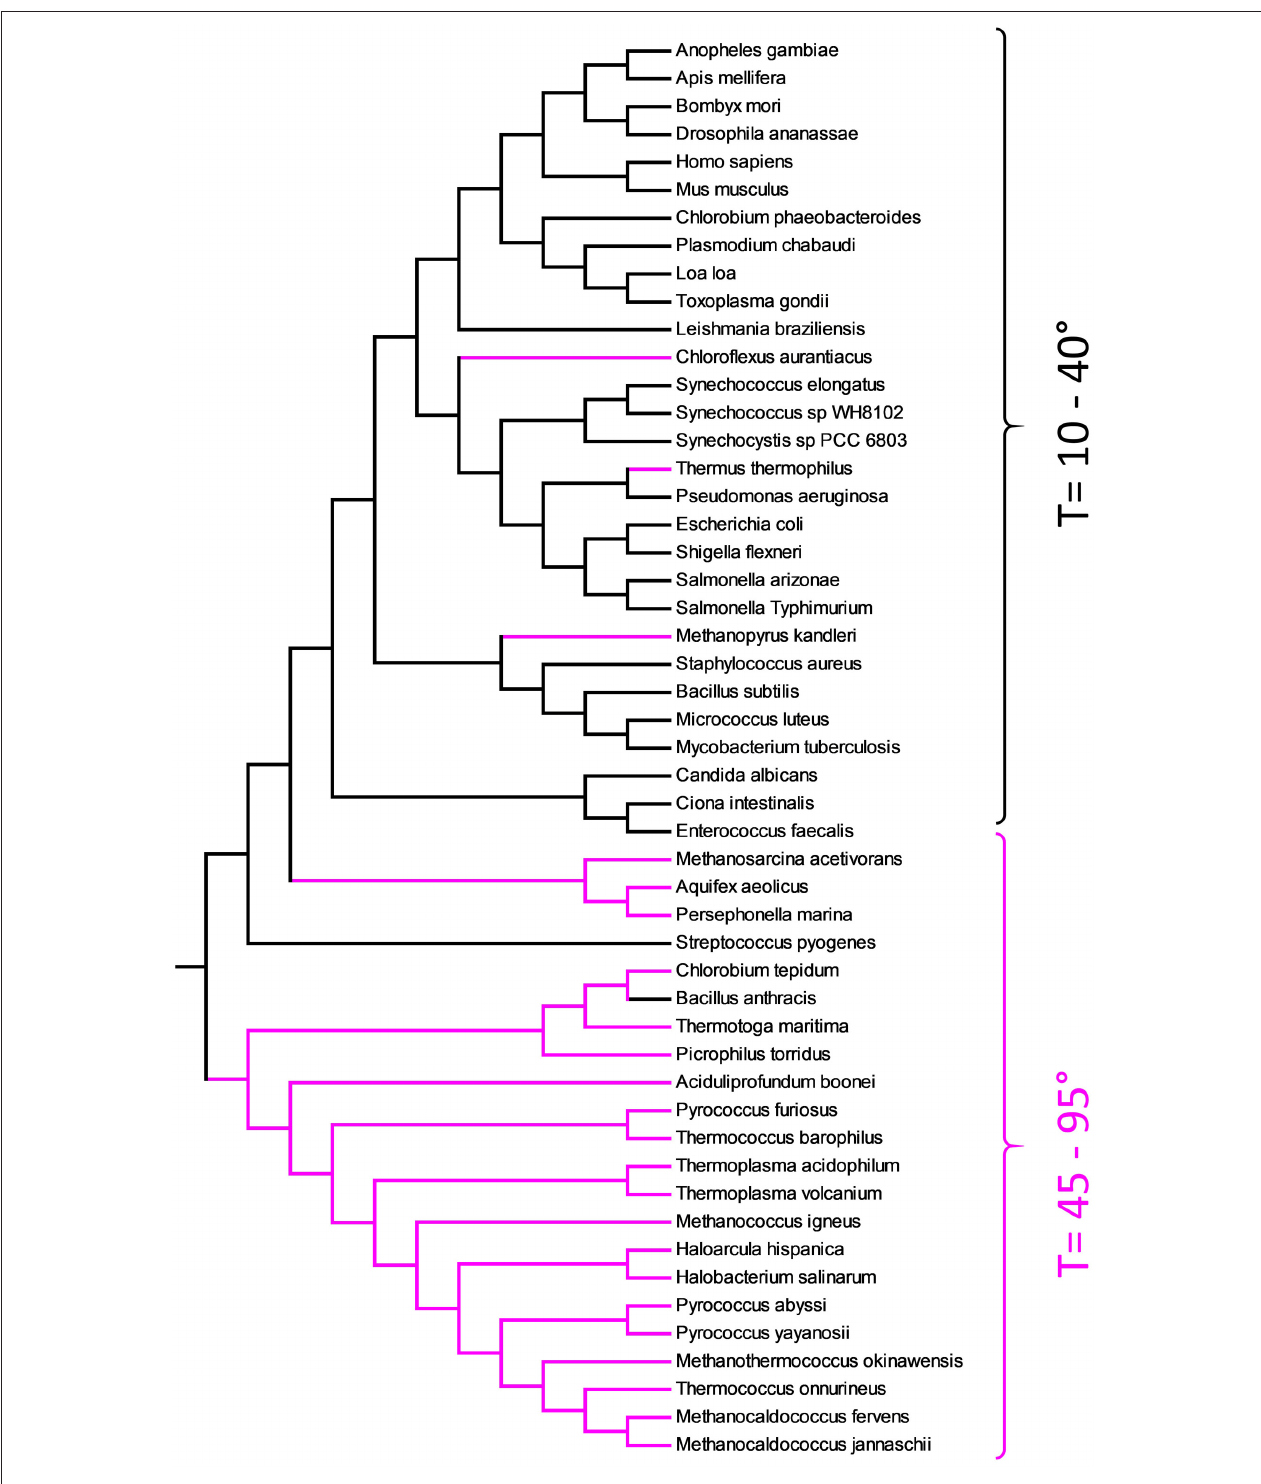
FIGURE 5 | Evolutionary relationships of TMP obtained with Equation (2) and substring length between 6 and 12. Thermophiles are shown in pink.